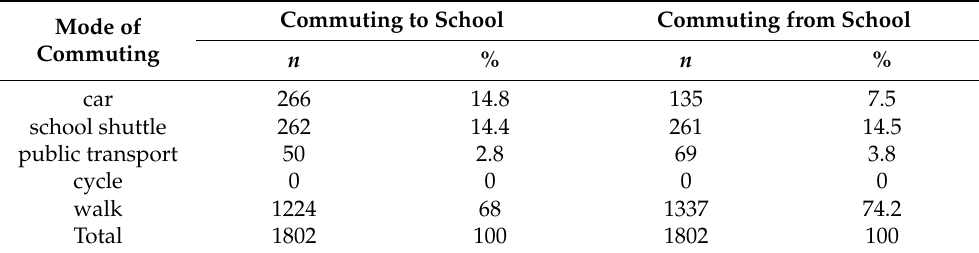
Table 3. Commuting mode shares among the